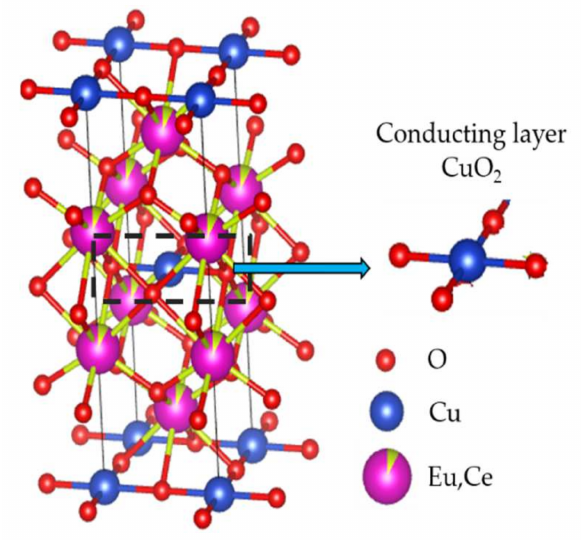
Figure 2. Crystal structure of Eu 2 − x Ce x Cu 1 − y Zn y O 4+ α − δ